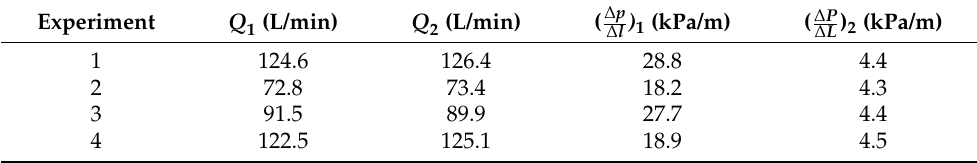
Table 5. Flow rates (L/min) and pressure drops (kPa/m) associated with each set of experiments.